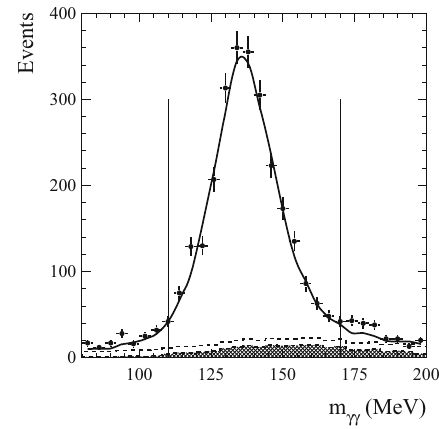
Fig. 2 The two-photon invariant mass distribution for selected data √ s = 1 . 28–1.52 GeV (points with error events from the energy region bars). The solid curve is the result of the fit described in the text. The dashed curve shows the total background contribution. The hatched histogram is the distribution for e + e − → π + π − π 0 π 0 background events. The lines indicate the boundaries of the mass window used in the dynamics study